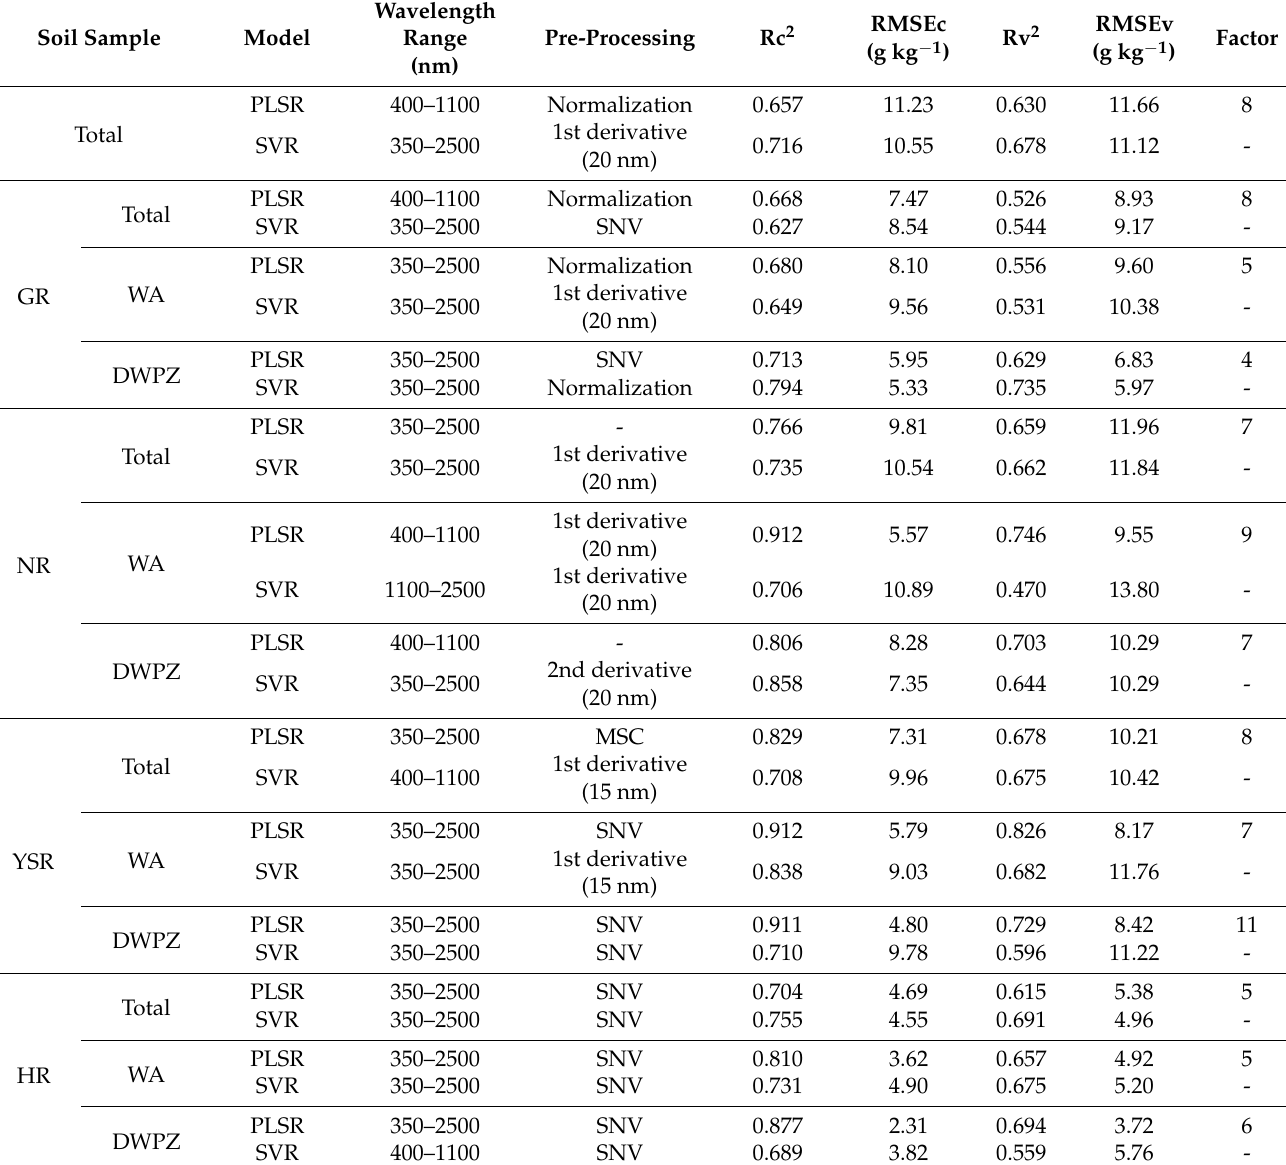
Table 3. The optimal SOM prediction model (PLSR or SVR) in the four major